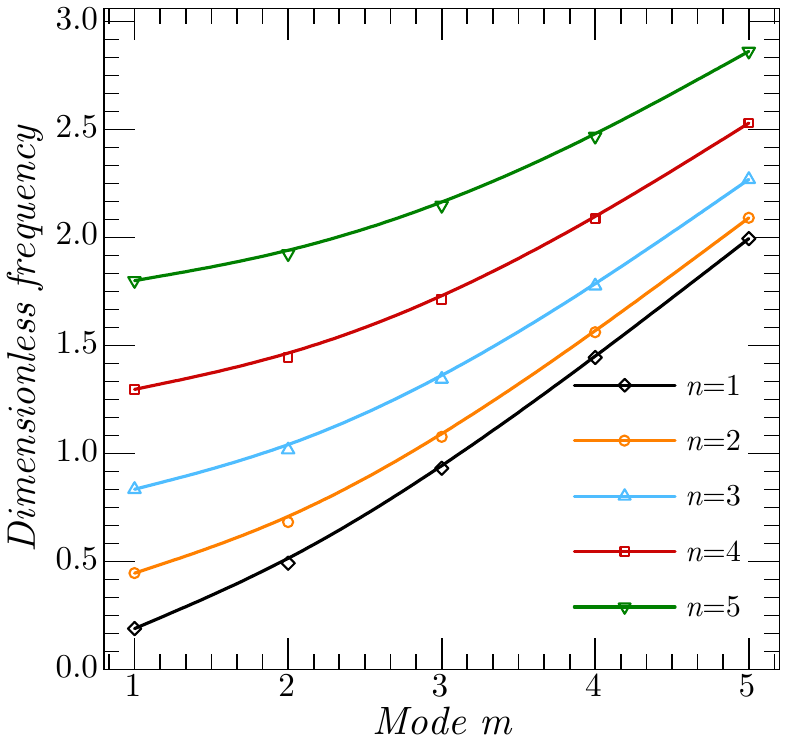
Figure 8. The effect of the modes of vibration “ m ” and “ n ” on the dimensionless frequency of a spherical shell ( R x = R y = 5 , SSSS, N = 9, b / a = 1, a / h = 10, V cnt = 0.01, V f max = 0.3, V f 0.1 ).